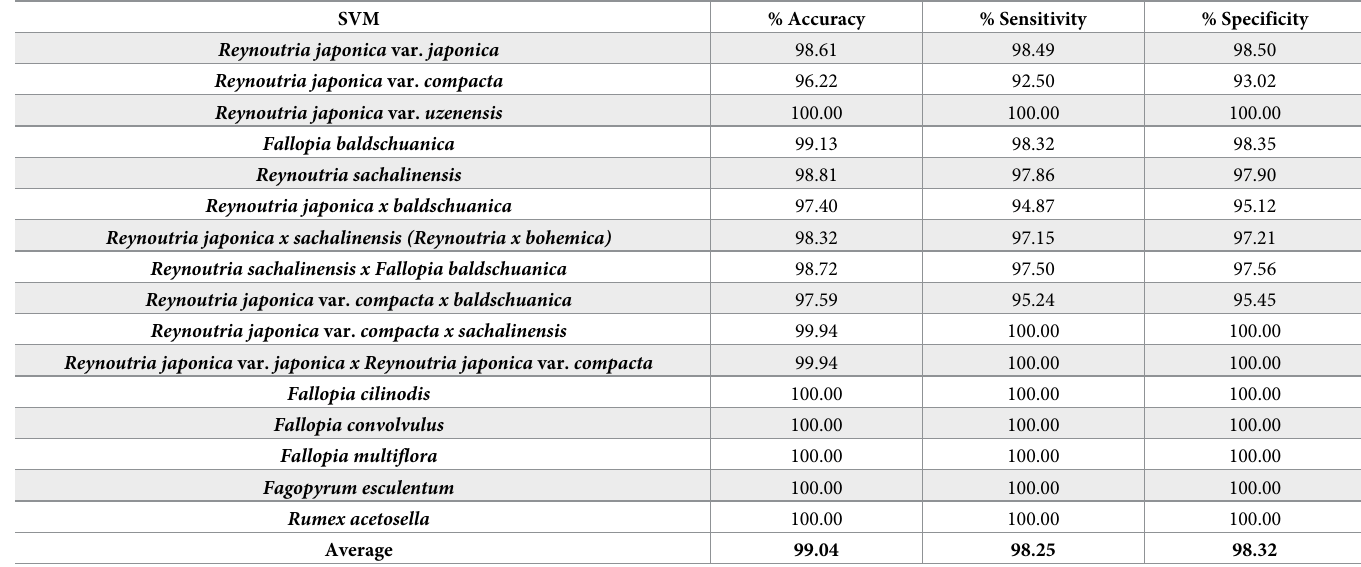
Table 2. Quality parameters (accuracy, sensitivity, and specificity) for spectral classification based on sample type of closely related species, hybrids, and varieties by SVM. SVM % Accuracy %